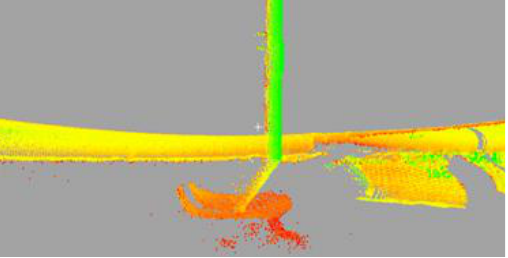
Figure 18. Three-dimensional laser scan before refraction correction for Trial 5 [36] (used with per- mission).